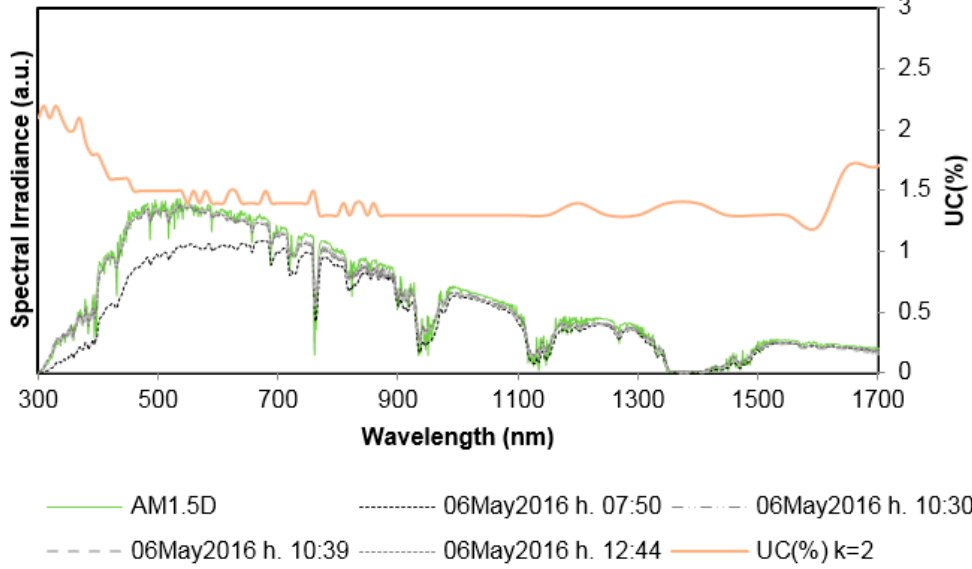
Figure 2. Measured spectra and reference spectrum AM1.5D ed.3 with the uncertainty function. The spectrum acquired at 07:50 would lead to SMR values outside the 3% limit, due to the low content in the UV and the visible. However, it has been included in the analysis to check that the results are applicable to all the hours of the day, and not only close to AM1.5D conditions.